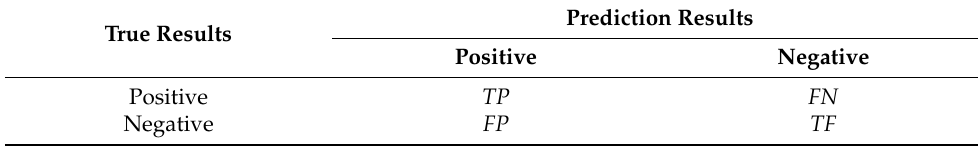
Table 10. Confusion matrix of prediction